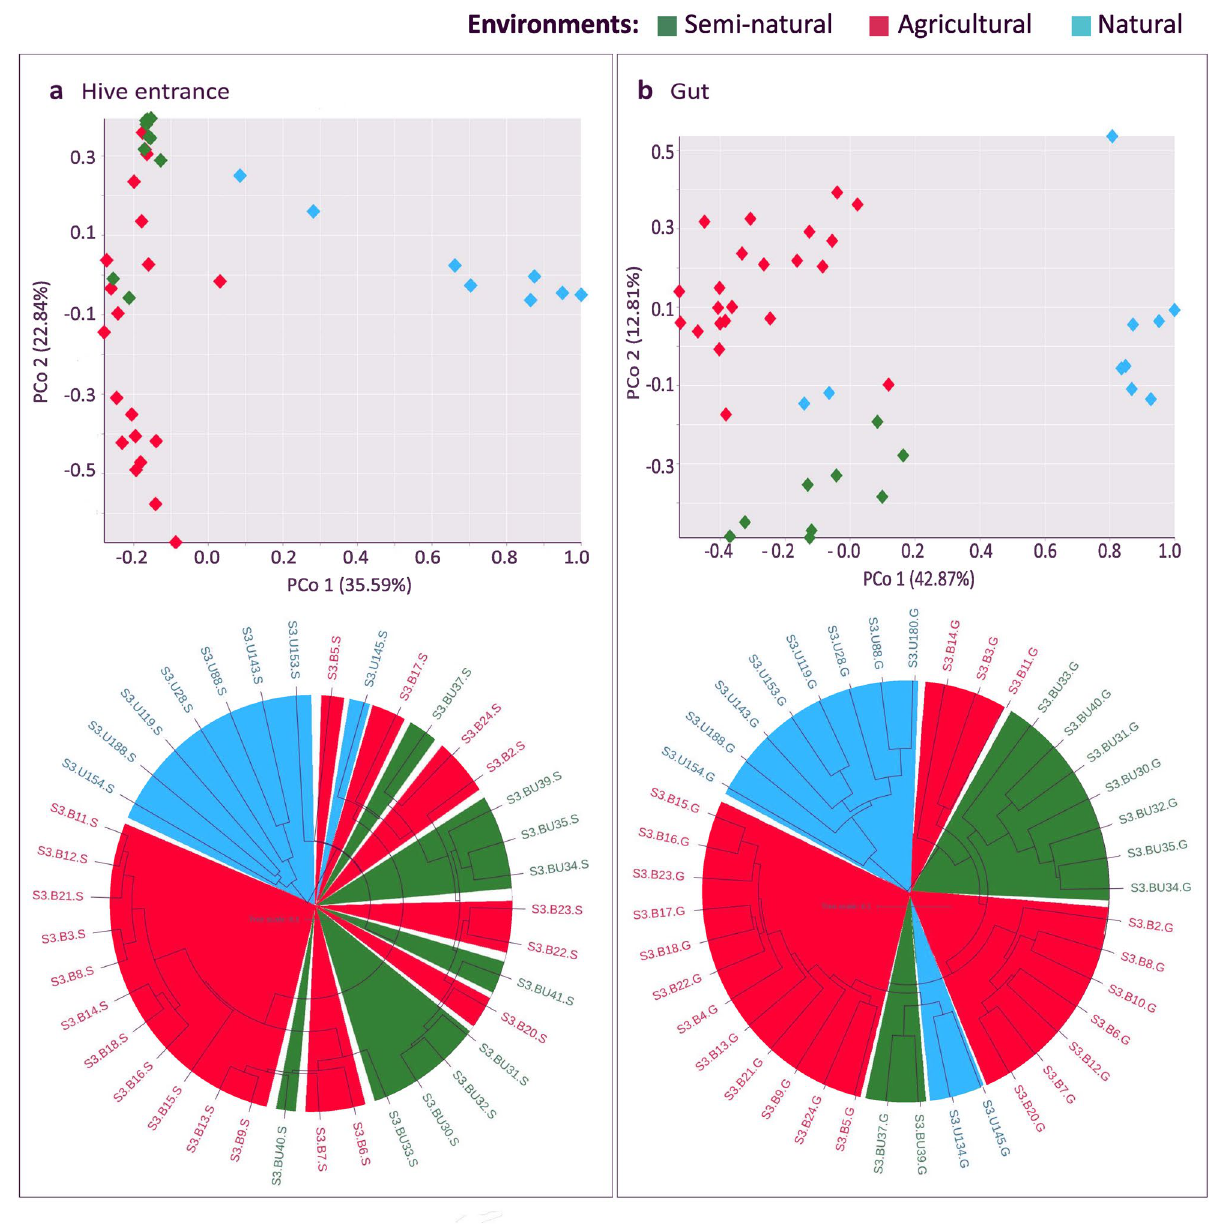
Figure 3. Beta diversity analysis of bacterial microbiota for hive entrance and gut samples. ( a ) Bray–Curtis based Principal Coordinate Analysis (PCoA) and UPGMA tree of hive entrance samples. Natural hives form an isolated cluster in the PCo1 axis. ( b ) Bray–Curtis based Principal Coordinate Analysis (PCoA) and UPGMA tree of adult worker gut samples, with clustering and isolation of all environments, and special differentiation for natural samples. Plotting: PCoAs were plotted using Vega editor (v5.22.1, https:// vega. github. io/ edito r/#/). UPGMA trees were visualized in iTOL (v6.5.8, https:// itol. embl. de/) and internal colors added via INKSCAPE (v0.92.3-1, https:// inksc ape.